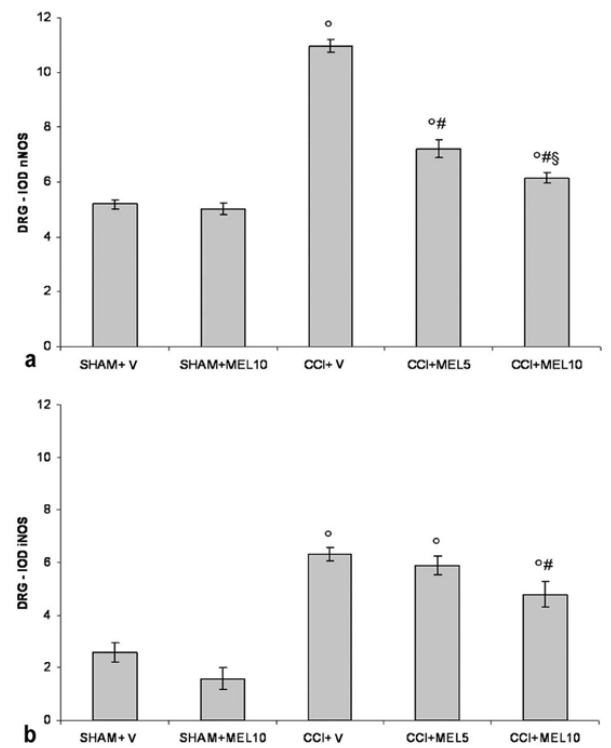
Figure 2. Constitutive (neuronal) isoform (nNOS) and inducible isoform (iNOS) evaluation in dorsal root ganglia (DRG). ( a ) Quantitative evaluation of nNOS immunopositivity in DRG (small size neurons − diameter < 30 µ m) as IOD (integrated optical density) in the experimental animals: sham-operated rats treated with 1% ethanol in saline (vehicle for melatonin) (SHAM + V); sham-operated rats treated with melatonin (10 mg/kg) (SHAM + MEL10); CCI rats treated with 1% ethanol in saline (vehicle for melatonin) (CCI + V); CCI rats treated with melatonin (5 mg/kg) (CCI + MEL5); CCI animals treated with melatonin (10 mg/kg) (CCI + MEL10). Data represent means ± SEM, ◦ p < 0.05 vs. SHAM + V, # p < 0.05 vs. CCI + V, § p < 0.05 vs. CCI + MEL5. ( b ) Quantitative evaluation of iNOS immunopositivity in dorsal root ganglia (DRG) (small size neurons − diameter < 30 µ m) as IOD (integrated optical density) in the experimental animals: sham-operated rats treated with 1% ethanol in saline (vehicle for melatonin) (SHAM + V); sham-operated rats treated with melatonin (10 mg/kg) (SHAM + MEL10); CCI rats treated with 1% ethanol in saline (vehicle for melatonin) (CCI + V); CCI rats treated with melatonin (5 mg/kg) (CCI + MEL5); CCI animals treated with melatonin (10 mg/kg) (CCI + MEL10). Data represent means ± SEM, ◦ p < 0.05 vs. SHAM + V, # p < 0.05 vs. CCI +